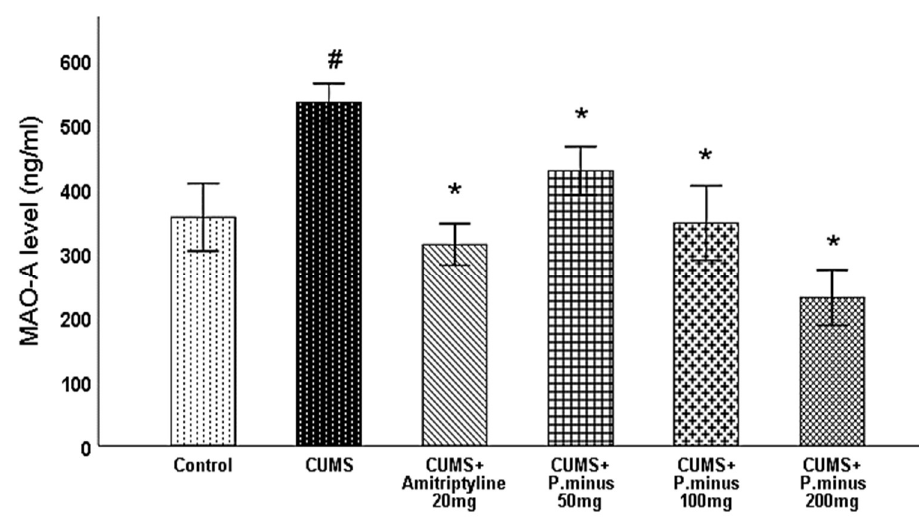
Figure 9. Effects of P. minus aqueous extract on MAO-A level (ng/mL) in CUMS induced depressive mice. # ( p < 0.05), vs. Control group; * ( p < 0.05), vs. CUMS group, ( n = 6).